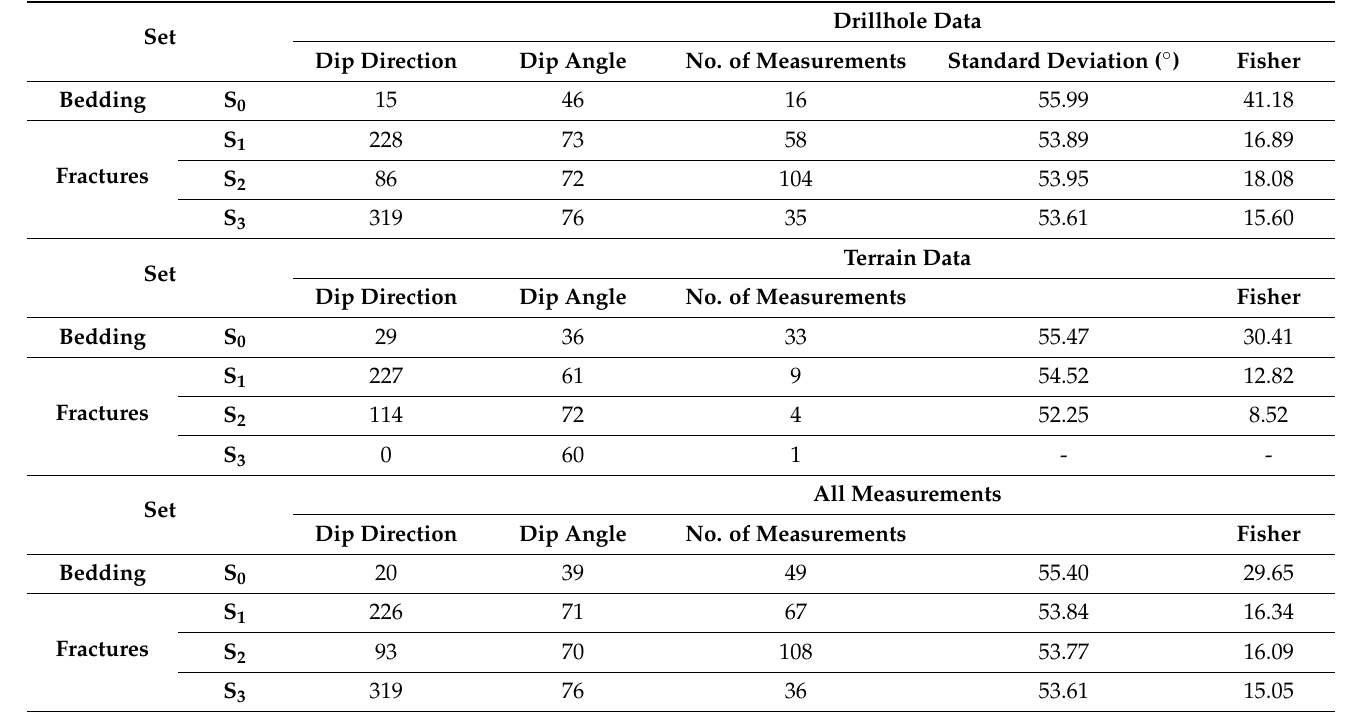
Table 1. Fracture orientation data and fracture set